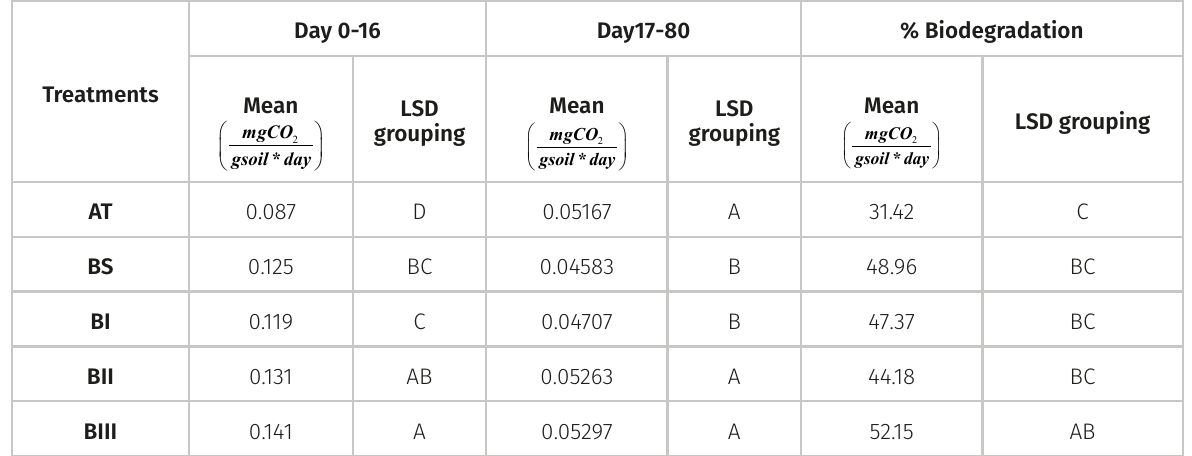
Table III. Daily production of carbon dioxide by Fisher’s LSD Test and Percentage of biodegradation applying Fisher’s LSD test.